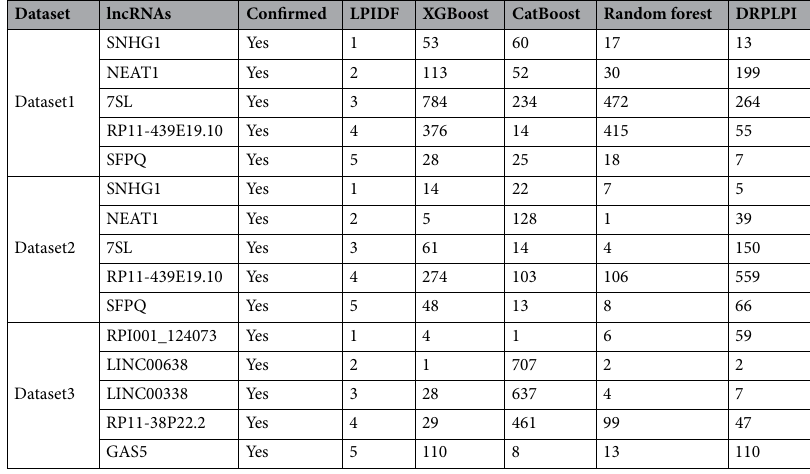
Table 6. The predicted top 5 lncRNAs interacting with Q13148.